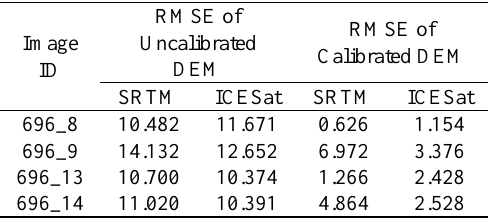
Table 5. DEM precision assessment (in unit: